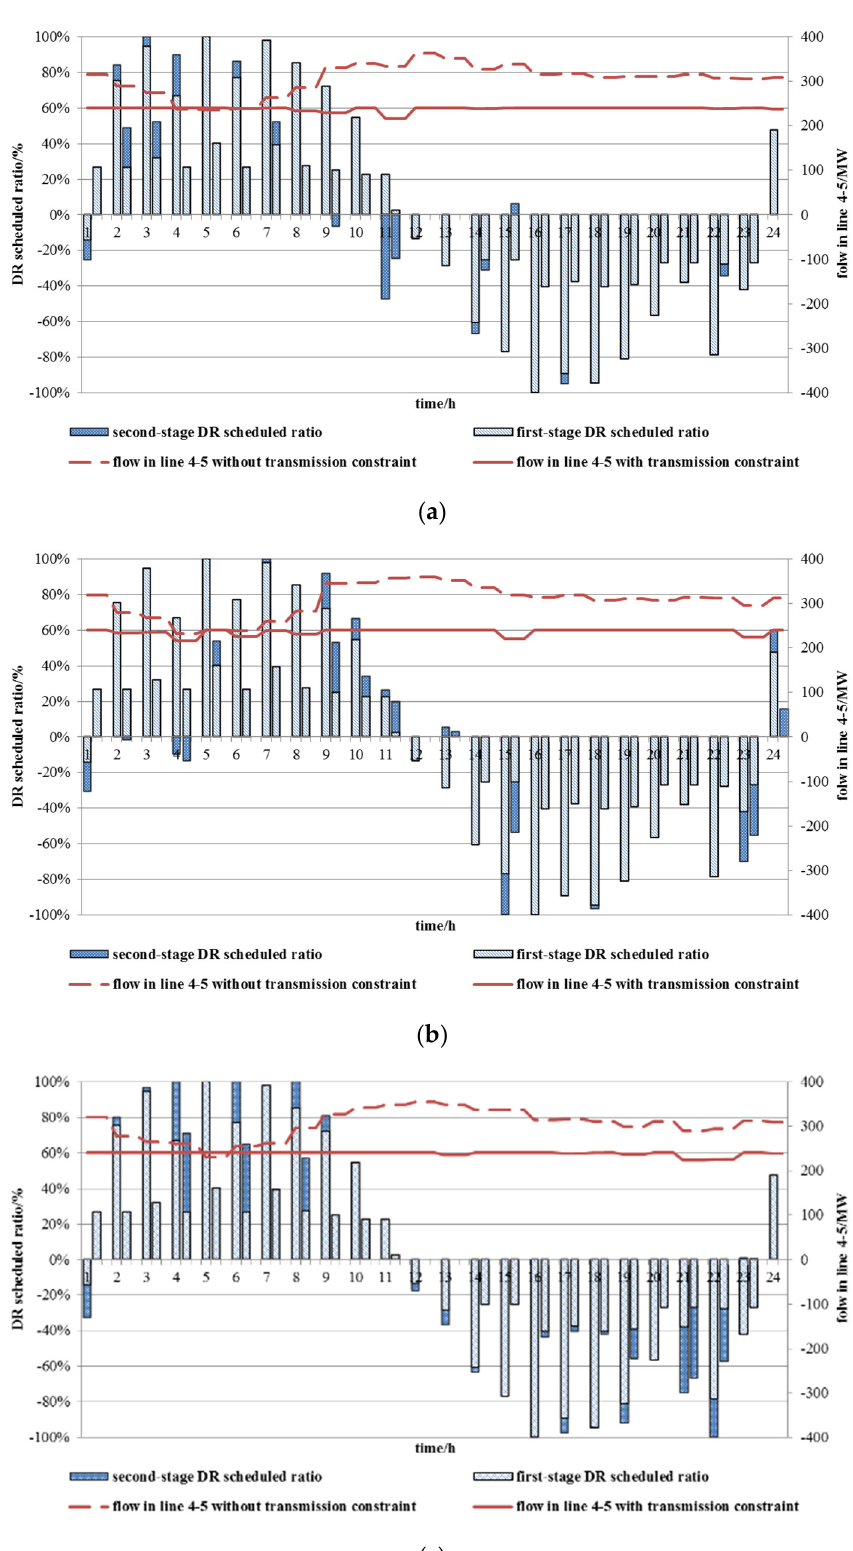
Figure 8. Proportion of DR scheduled in two stages and power flow of lines 4–5. In the transmission constraint case, the flow in lines 4–5 is limited to 240 MW during most hours of all scenarios due to congestion. Meanwhile, more DR resources are dispatched in the first stage (DR on a day ‐ ahead basis, which has lower operating cost) rather than in the second stage (DR on an intra ‐ day basis, which has higher operating cost). ( a ) Results of scenario 1; ( b ) Results of scenario 2; ( c ) Results of scenario 3.